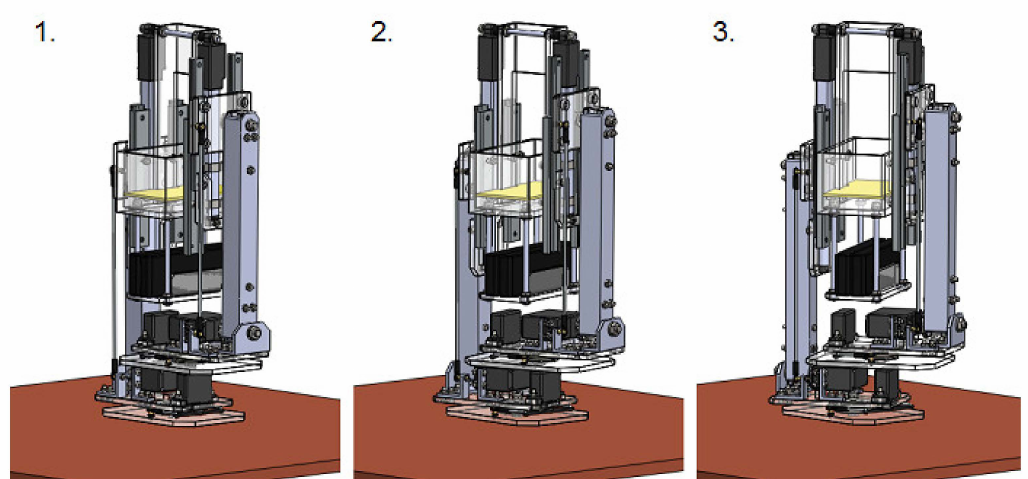
Figure 17. Snapshot sequence from the robot rotation simulation. Legends: 1—both legs of the robot are in a vertical plane and at the same time the robot is standing on the right foot; 2—the rotary actuator rotates the rotary pad by the required angle of rotation; 3—the robot is in the target position of the angle of rotation and is ready to lower down the left foot and transfer the center of gravity of the robot to it and then raise the right foot and rotate the right rotary actuator to return the right rotary pad to its original position.